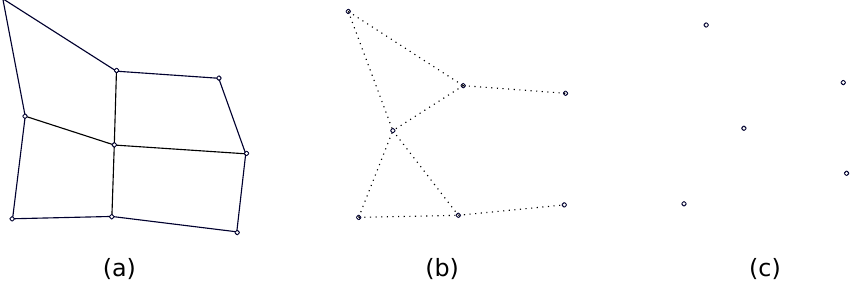
Figure 3. An example of lattice structure of SOM ( a ), (G)NG ( b ) and K-means ( c